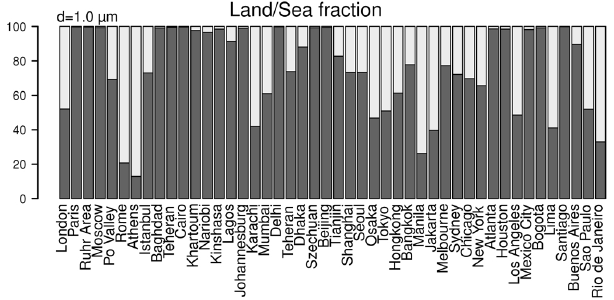
Fig. 6. Example for land–sea fractionation in % of D 1 for the NS act 1.0µm aerosol tracers. Dark gray bars represent the land fractions, light gray bars the sea